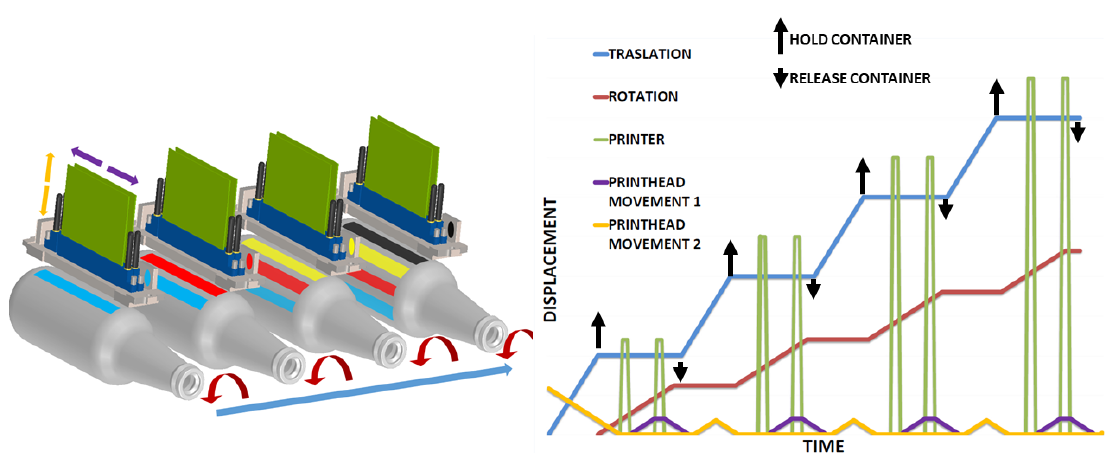
Figure 4. Topology phase diagram topology 1.